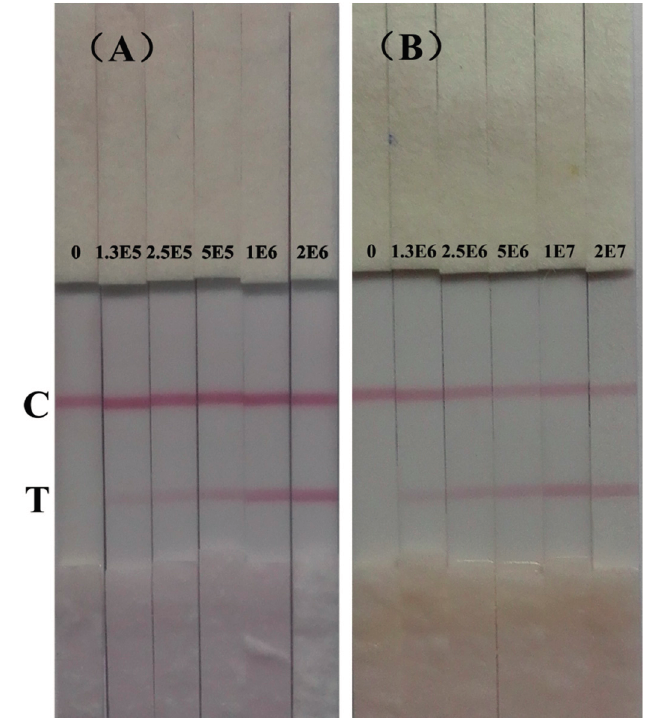
Figure 3. Immunochromatographic strip for detection of S. typhimurium (cfu/mL) . ( A ) in PBST; ( B ) in pure